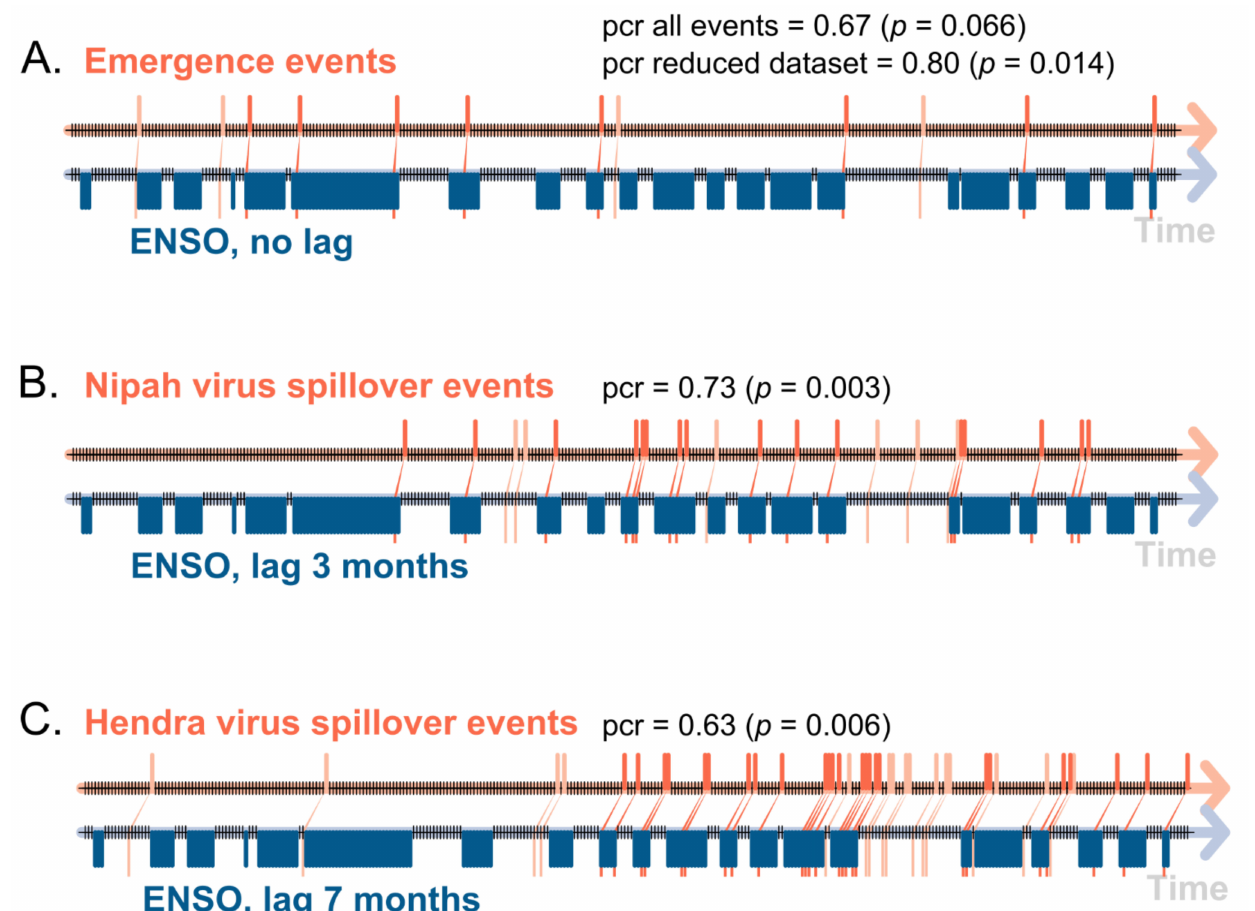
Figure 5. Event coincidence analyses of the association between ( A ) an emergence event of bat-borne virus in the Asia–Pacific region and the Arabian Peninsula, ( B ) a spillover event of the Nipah virus in Bangladesh, and ( C ) a spillover event of the Hendra virus in Australia with an ENSO event (El Niño or La Niña phases) with values of precursor coincidence rate (pcr) and its associated probability and lag value between paired events (lags values used for Nipah virus and Hendra virus analyses correspond to the results of cross-temporal series correlations, shown in Figure 3 and Table